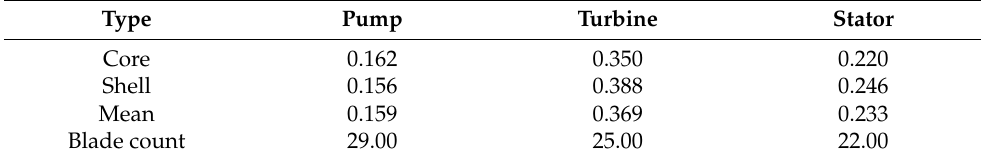
Table 1. The unit camberline peak height of the original model.